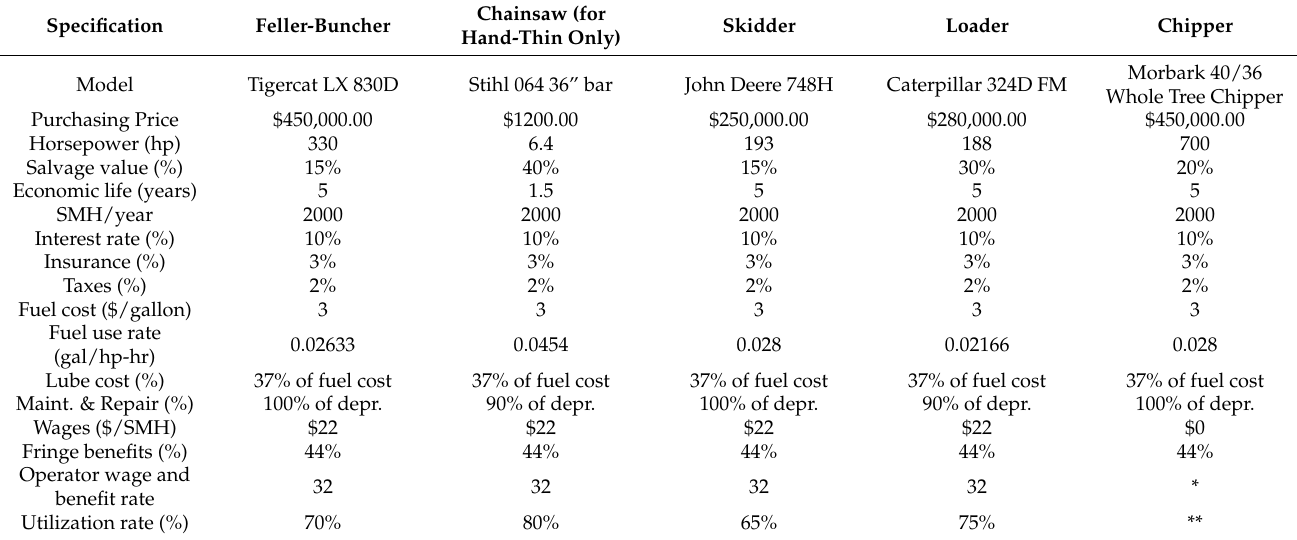
Table 2. Machine types and specifications, based on machines used by local operators. Specification